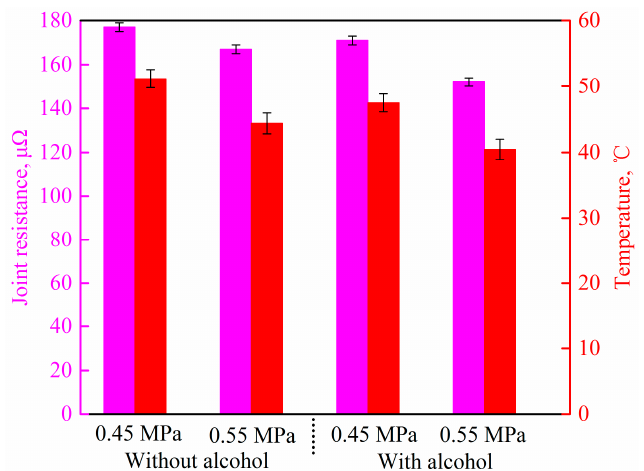
Figure 8. Joint resistance after 200 A current flow for 60 s time and the corresponding peak temper- ature at the weld